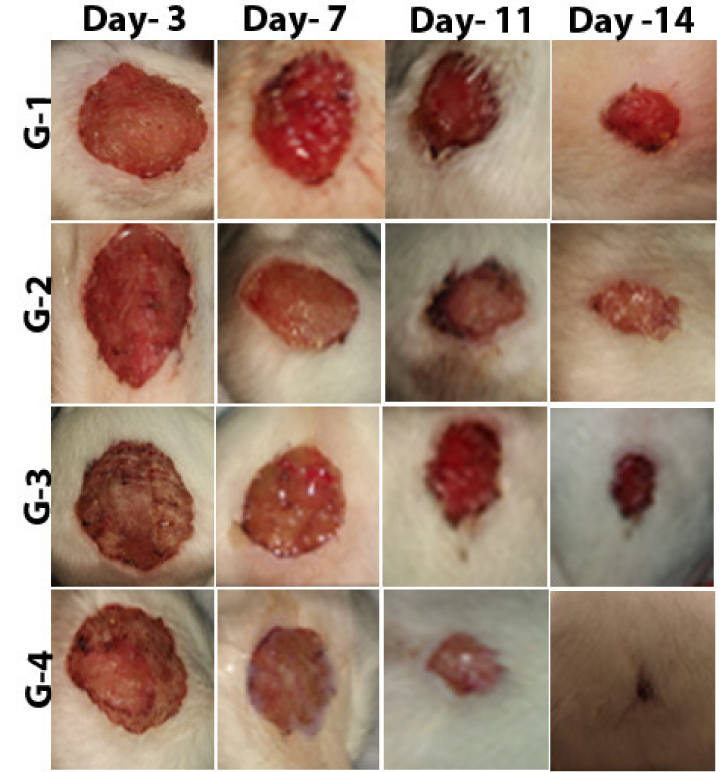
Figure 6. The stages of wound recovery in wound area within 14 days of wounding in Group G-1 (infected and untreated control), Group G-2 (uninfected and untreated control), Group G-3 (infected and treated with imipenem), and Group G-4 (infected and treated with